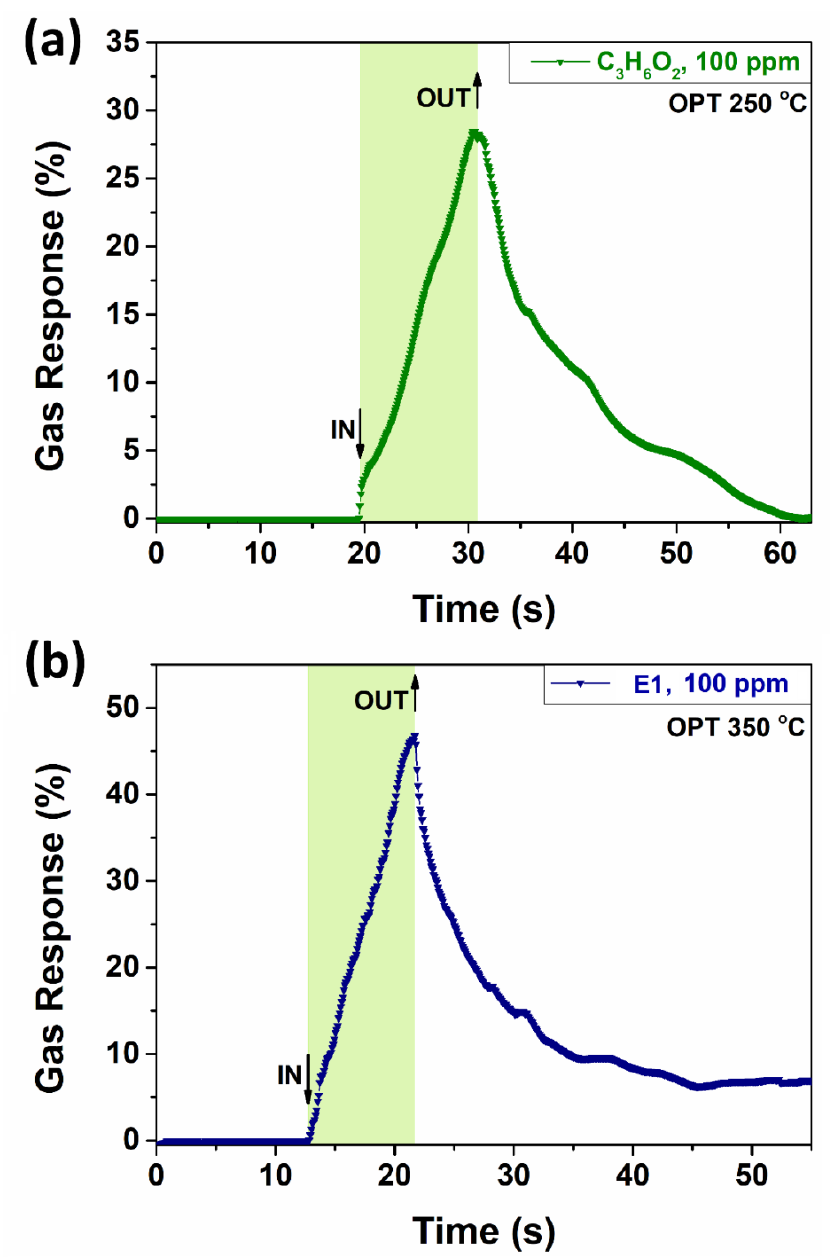
Figure 12. Dynamic response to 100 ppm vapor for the 3D printed copper and iron oxide sensors to: ( a ) C 3 H 6 O 2 ; and ( b ) LiNO 3 or E1.